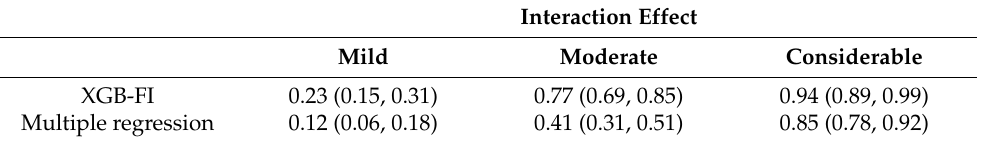
Table 3. Power comparisons between the XGB-FI and multiple regression with sample size 1000.